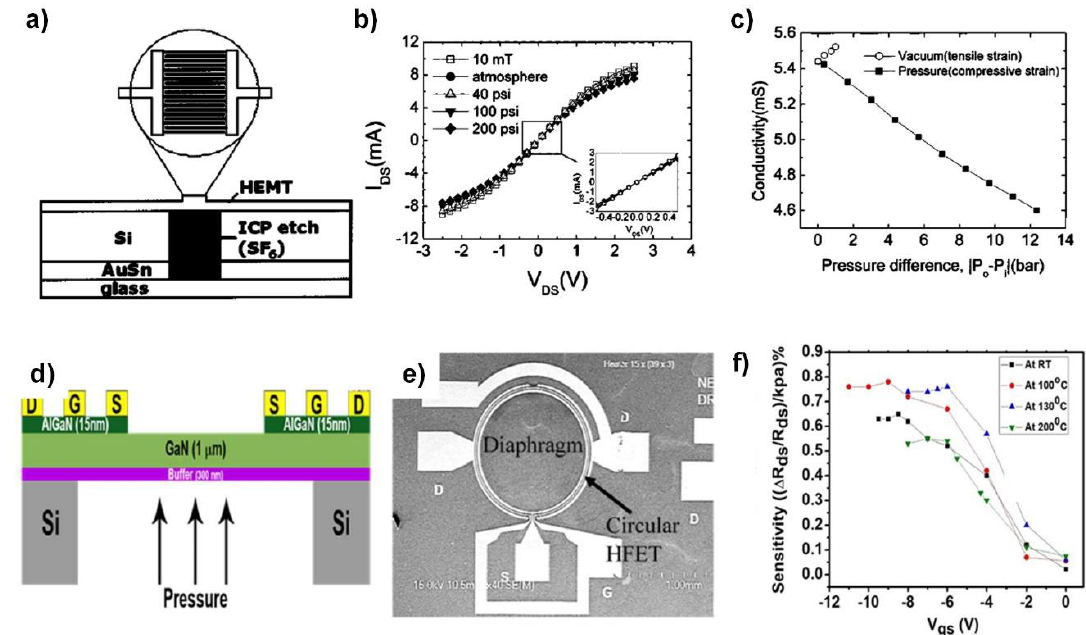
Figure 8. GaN-based devices for pressure sensing applications. ( a ) Cross-sectional diagram of the AlGaN/GaN HEMT device fabricated on a membrane on a Si substrate. ( b ) The I-V characteristics of the device as a function of applied pressure. ( c ) Channel conductivity of the HEMT membrane as a function of differential pressure. ( a – c ) Reproduced from [51] with permission from the American Institute of Physics. Copyright 2004. ( d ) Schematic illustration of ring-shaped AlGaN/GaN HFET. ( e ) SEM image in the channel area. ( f ) Sensitivity of the device measured at different temperatures. ( d – f ) Reproduced from [49] with permission from MDPI. Copyright 2018. Table 7. A comparison of GaN-based thin-film pressure and strain sensors.